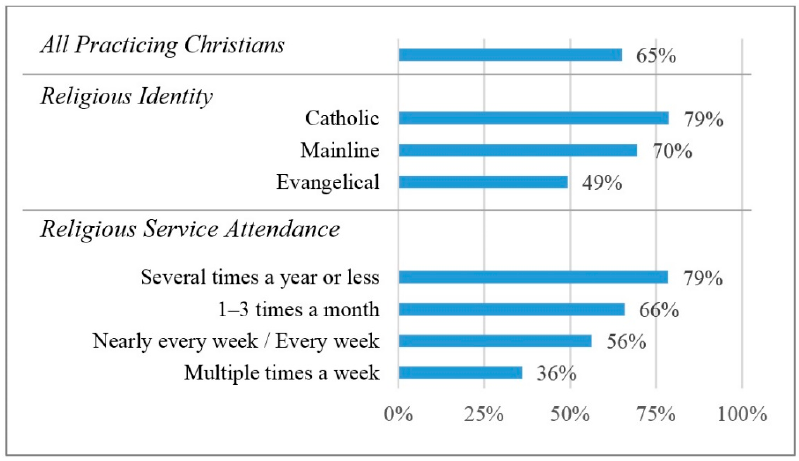
Figure 3. % of people who say they do not participate in discussion groups about faith and work (overall and by subgroup). (overall and by